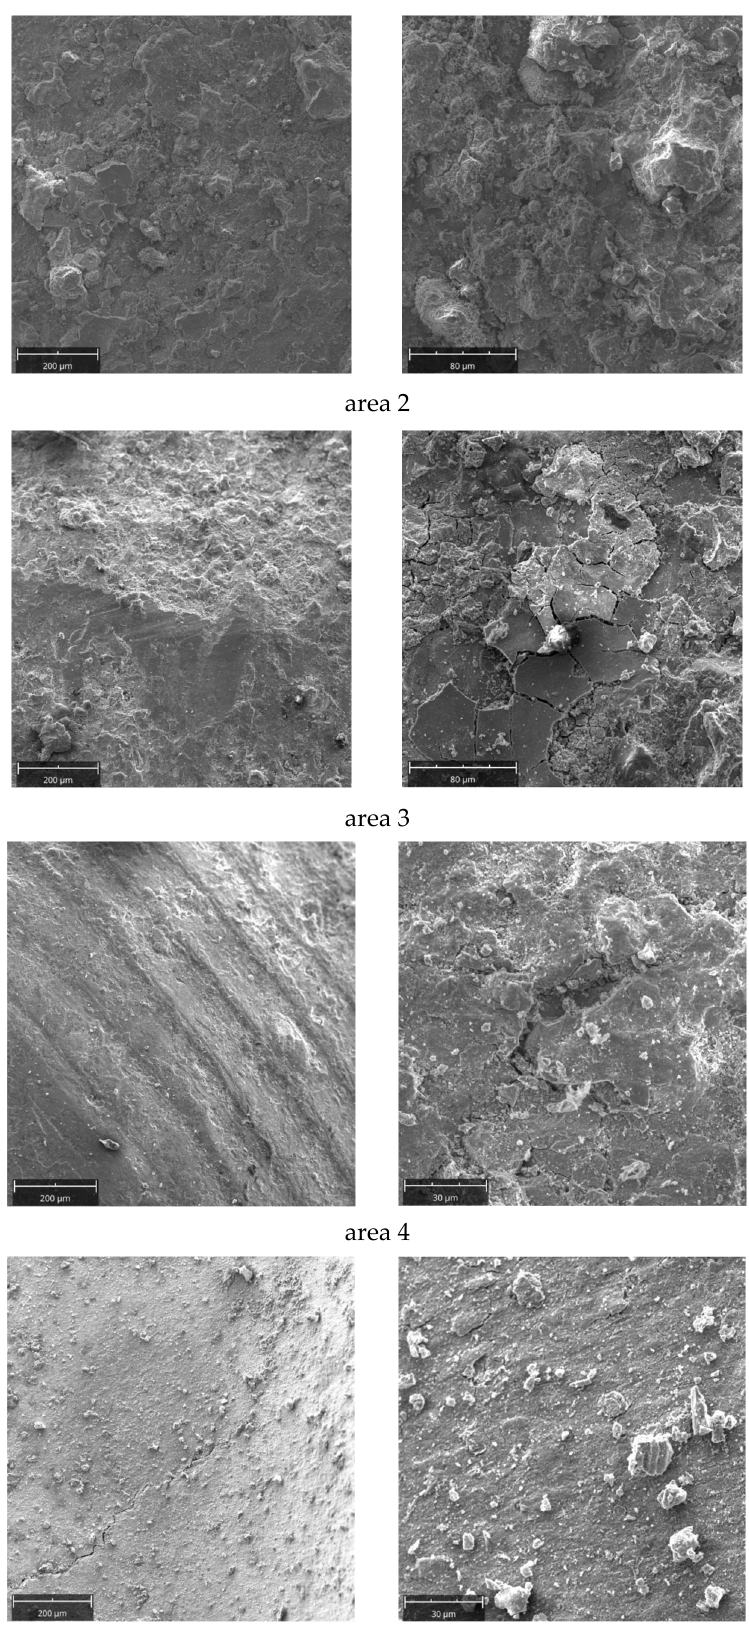
Figure 14. A fragment of the die selected to study its surface. Four areas ( 1 – 4 ) analyzed are marked: ( a ) low magnification, ( b ) high magnification.